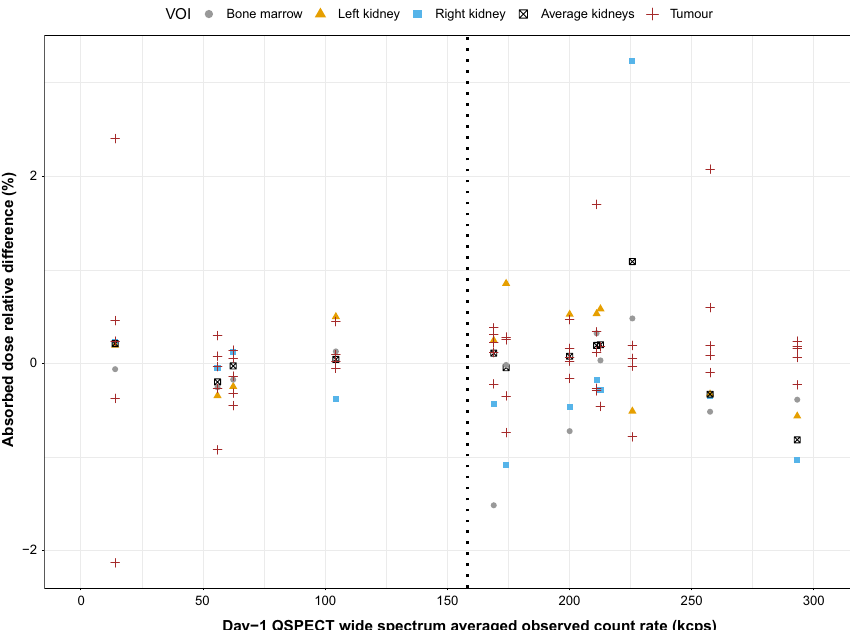
Fig. 5 Relative difference between self‑absorbed dose estimates computed from two‑timepoint QSPECT corrected for dead time using DTCM3 versus DTCM1, in function of the Day‑1 observed wide‑spectrum count rate. The dotted line at 158 kcps corresponds to a DTCF equal to